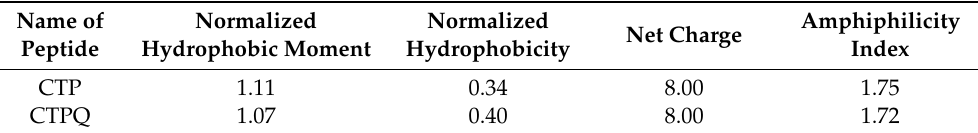
Table 1. Sequence and physicochemical properties of CTPs.